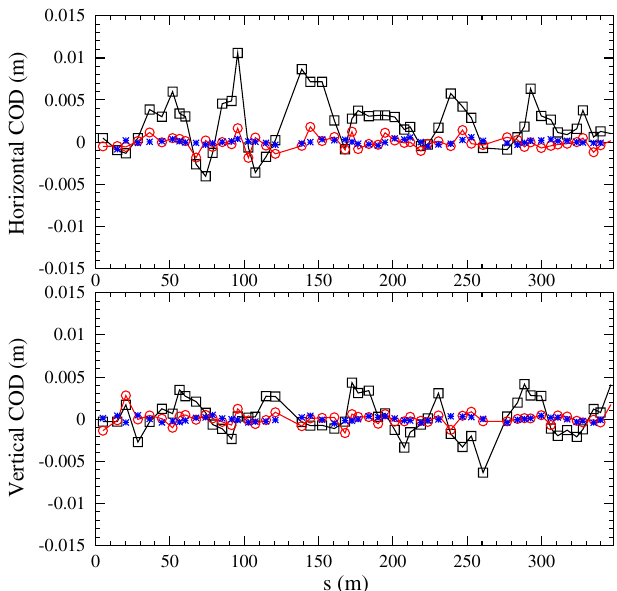
FIG. 5. (Color) Horizontal (upper) and vertical (lower) COD measured on ring-BPM’s in the beam storage mode before (black squares) and after (red circles) the COD correction, where blue asterisks show the COD difference when the injection-orbit bump is turned on and